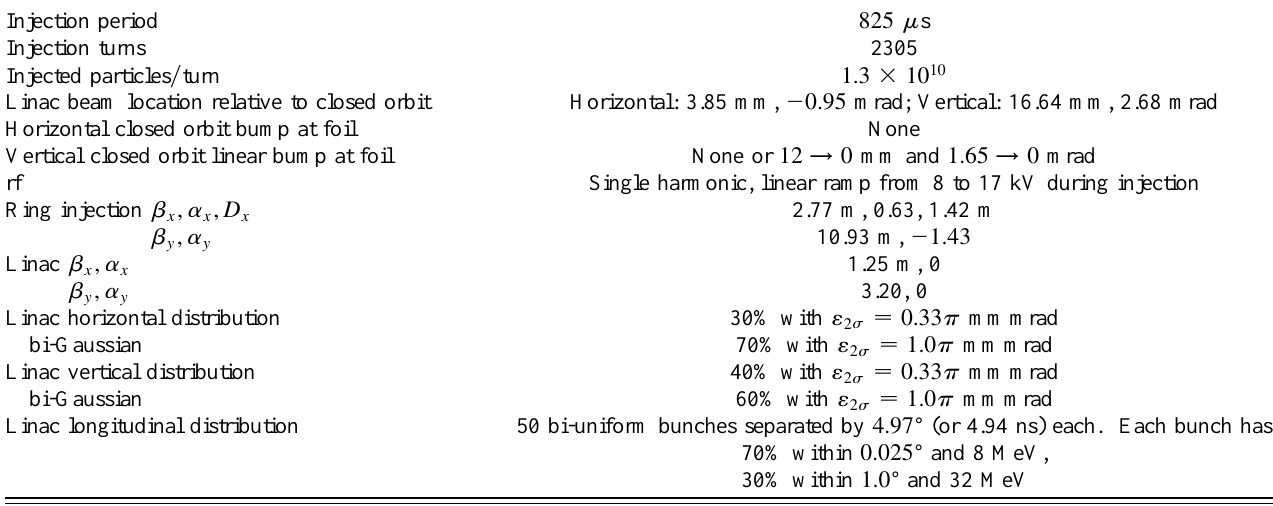
TABLE I. Input parameters used to model the PSR injection scenario.